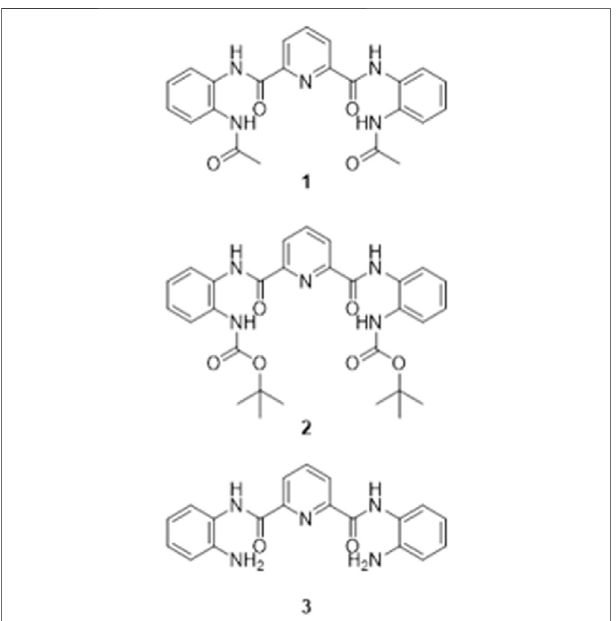
FIGURE 1 | Short chain aromatic oligoamides 1 – 3 employed in this study.